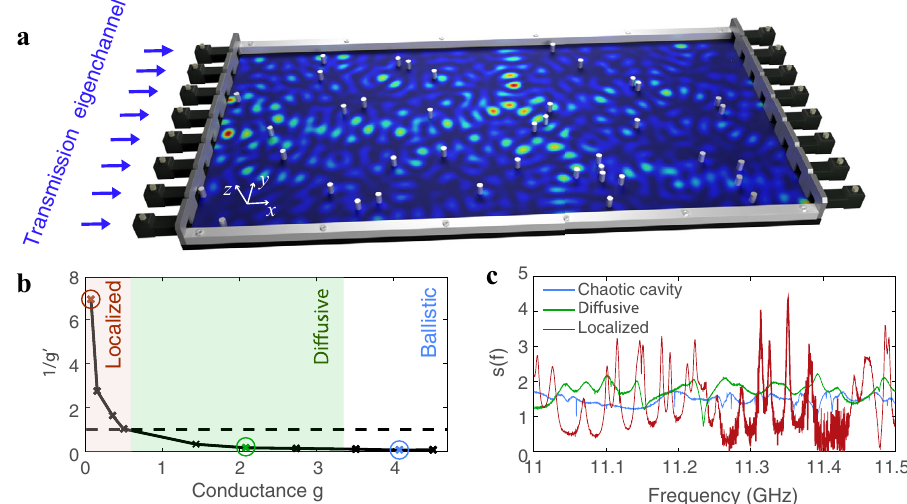
Fig. 1 Experimental setup and path length spectra. a Sketch of the experimental setup, where the cavity is represented for a random arrangement of 40 aluminum cylinders. The top plate has been removed to visualize the interior of the sample. The embedded intensity distribution corresponds to the highest transmitting transmission eigenstate in this scattering con fi guration obtained from a numerical simulation. b Experimental data for the variation of the inverse of the statistical conductance, ð 1 = g 0 Þ ¼ 3var ð s a Þ = 2 as a function of the conductance g to estimate whether the experiment operates in the diffusive ½ð 1 = g 0 Þ < 1 (cid:2) (green shaded area) or in the localized regime ½ð 1 = g 0 Þ > 1 (cid:2) (red shaded area) 21 . c Spectra of the mean path length s ( ω ) = s [2 Q chaotic cavity (blue line), a diffusive sample with n scat = 100 scatterers (green line) and a localized sample with n scat = 280 scatterers (red line). The values of 1 = g 0 corresponding to these samples are shown with red, green and blue markers in ( b